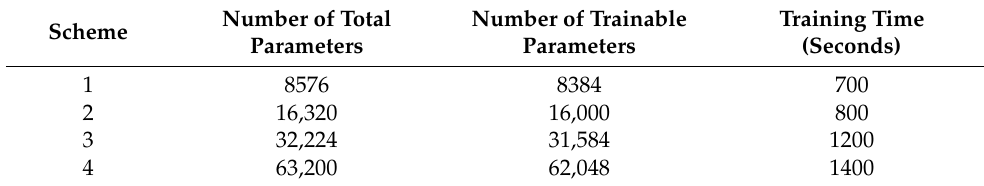
Table 4. The number of parameters and average training time of the four schemes.